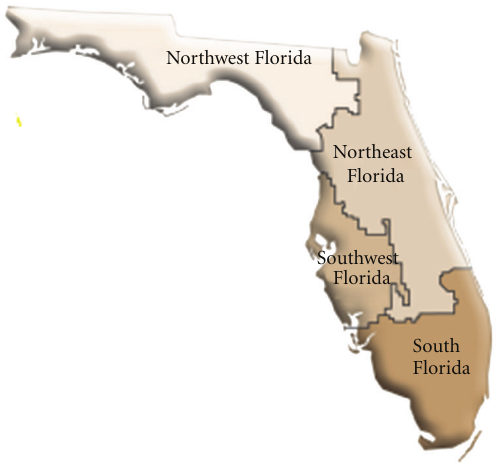
Figure 2: Map of Florida depicting the four regions of the State